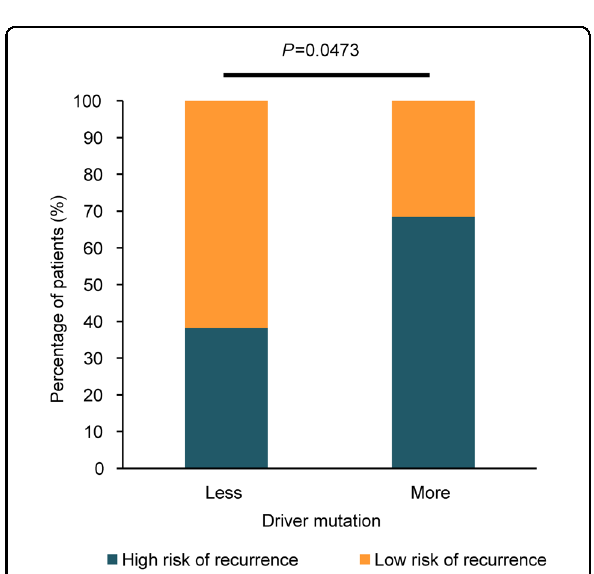
Fig. 5 Driver mutation number in relation to the mortality rate of SCLC. SCLC patients with more driver mutation number showed a higher 1-year mortality rate (68%) than those with less driver mutation number (38%, Fisher ’ s exact test, P â €‰ = â €‰